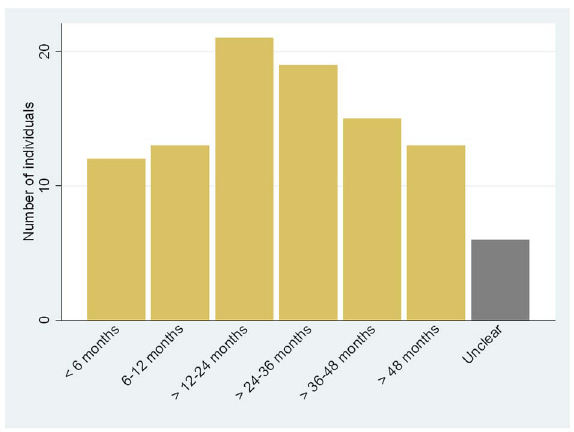
Figure 2. Duration of ENL.